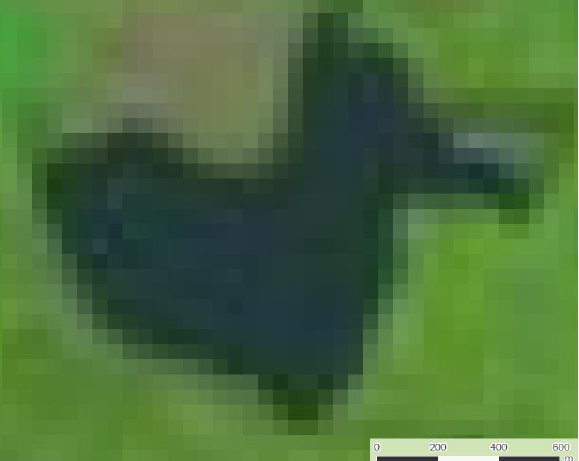
Figure 1. Detail of Pohránovský pond in Landsat 8 image